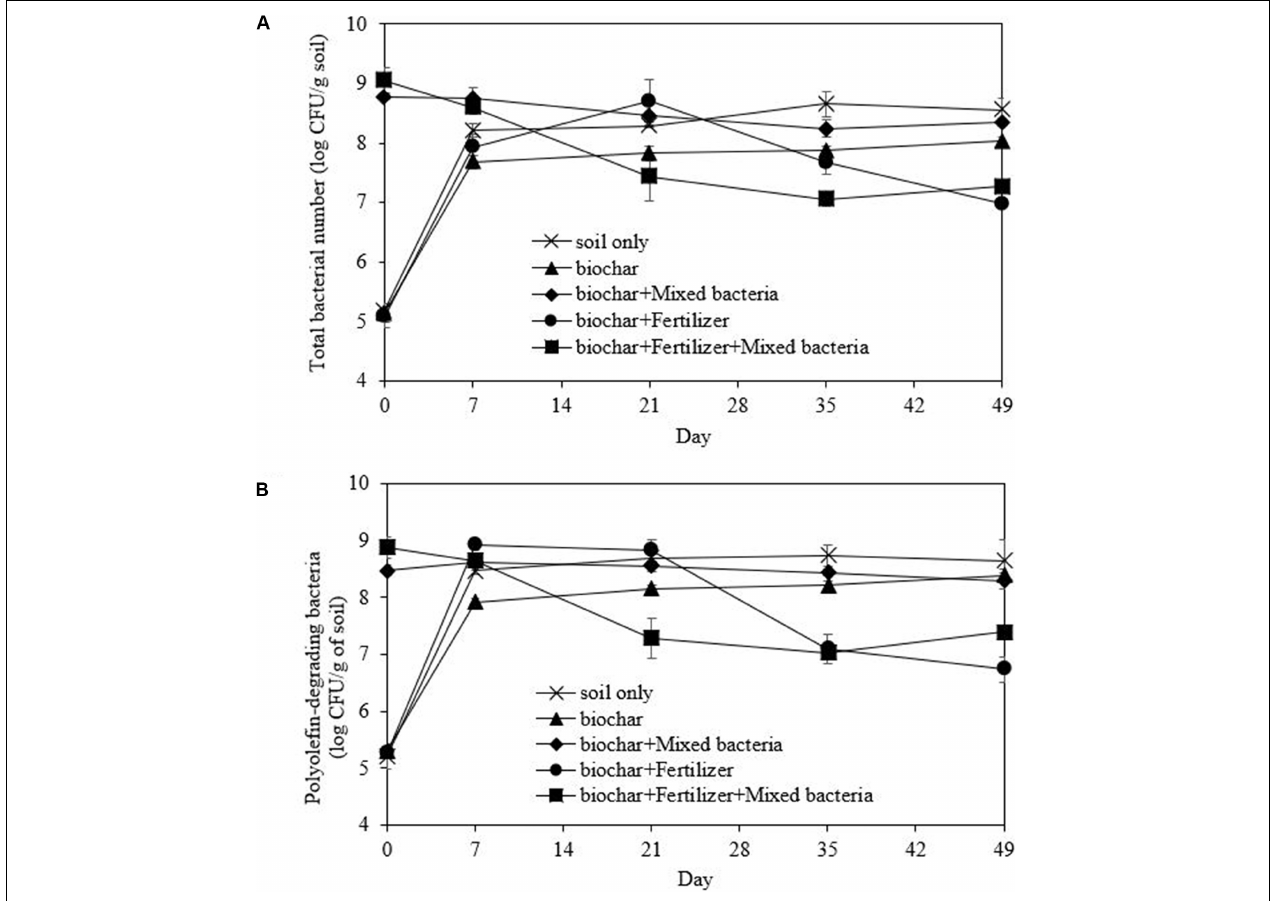
FIGURE 7 | Changes in number of total bacteria (A) and polyolefin-degrading bacteria (B) during the bioremediation of drill cuttings after washing in a scale-up